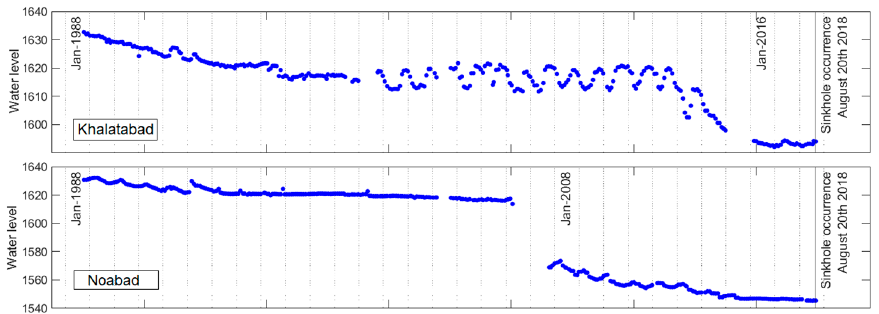
Figure 11. Piezometric records for Khalatabad and Noabad wells from 1998 to 2018. The vertical axis represents water level.